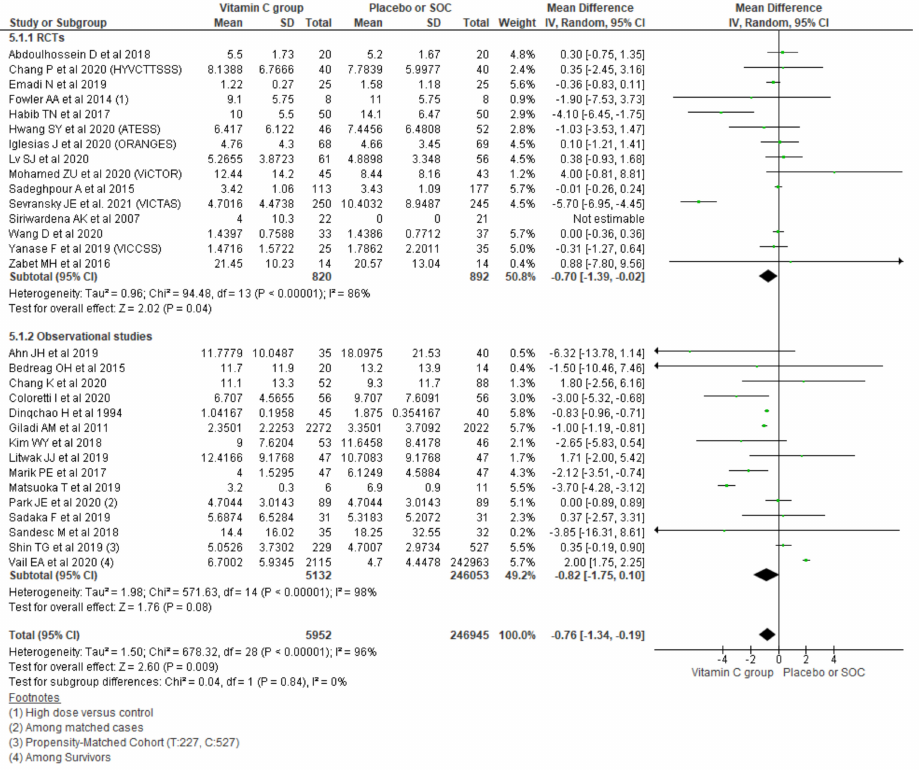
Figure 6. Forest plot showing mean difference of length of ICU stays using a random-effect